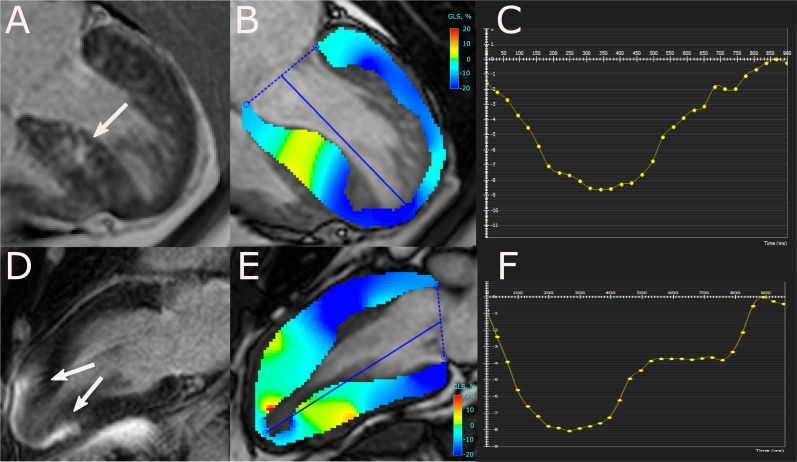
Representative images of patients with asymmetric (A-C) and apical HCM (D-F). Depicted are 4- (A) and 2-chamber (D) PSIR images with late gadolinium enhancement (LGE) (arrows), peak systolic longitudinal strain maps superimposed on corresponding cine-images (B, E), and resulting longitudinal strain curves. Areas of large confluent LGE (A, D) and regions with significantly attenuated strain (B, E) overlap. The patient with asymmetric HCM had an indexed left ventricular (LV) mass of 83 g/m2, LGE extent of 22.8%, and a GLS of -9.8%. The patient with apical HCM had an indexed LV mass of 63 g/m2, LGE extent of 20.3%, and a GLS of -8.9%.